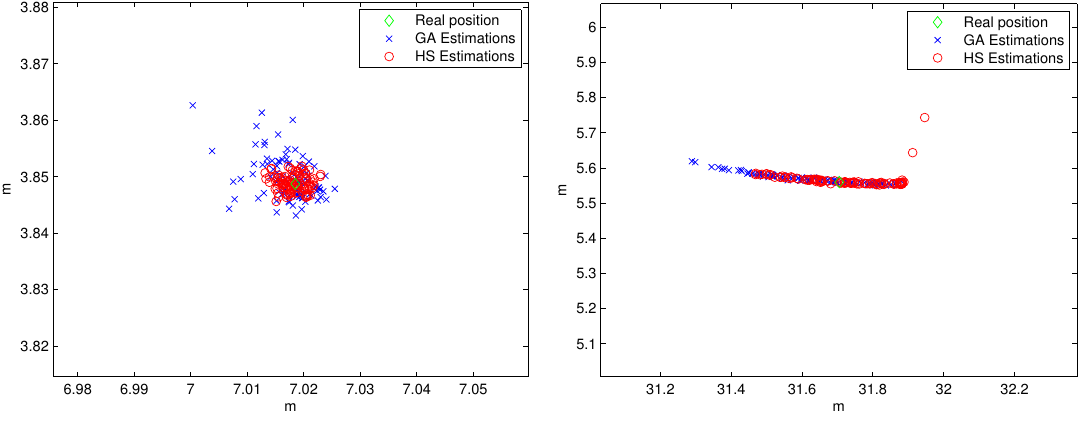
Figure 8. Simulated results for the estimations of beacon #1 (left) and beacon #2 (right).